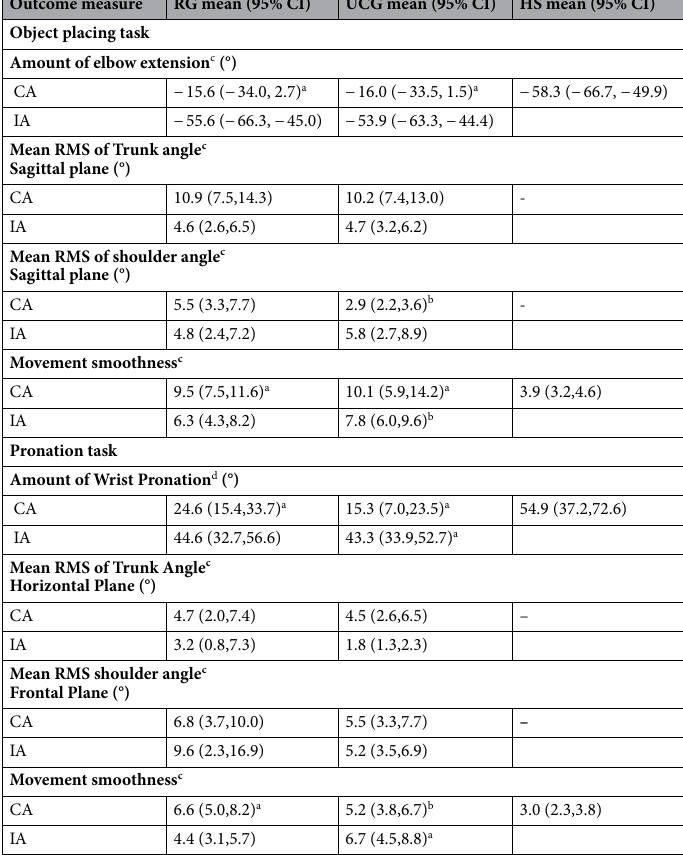
Table 2. Mean and 95% confidence interval of instrumented parameters for post-stroke subjects at baseline (allocated to Robot Group (RG) and Usual Care Group (UCG)) and for Healthy Subjects (HS). a Statistically significant different with respect to HS. b Statistically significant different with respect to RG. c Lower values indicate better performance. d Higher values indicate better performance. RMS, root mean square; CA, Contralesional arm; IA, Ipsilesional